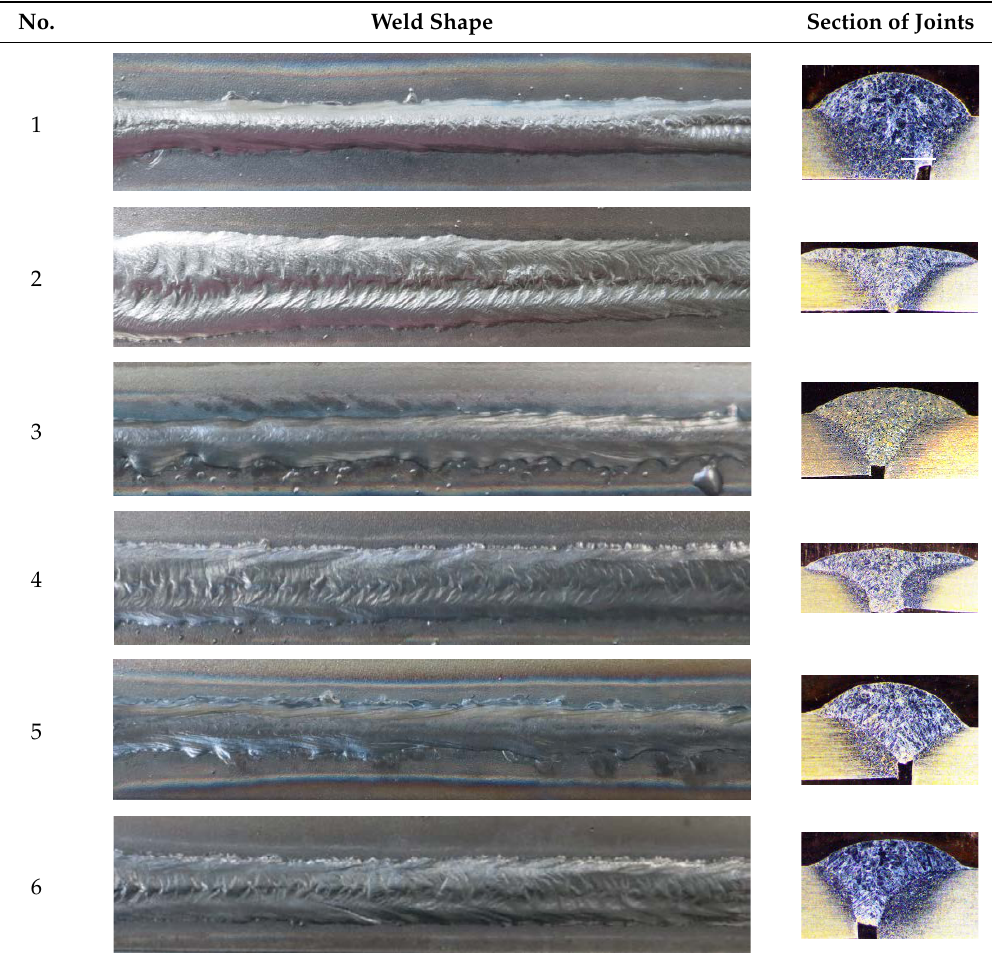
Table 3. The weld shape and section of joints.